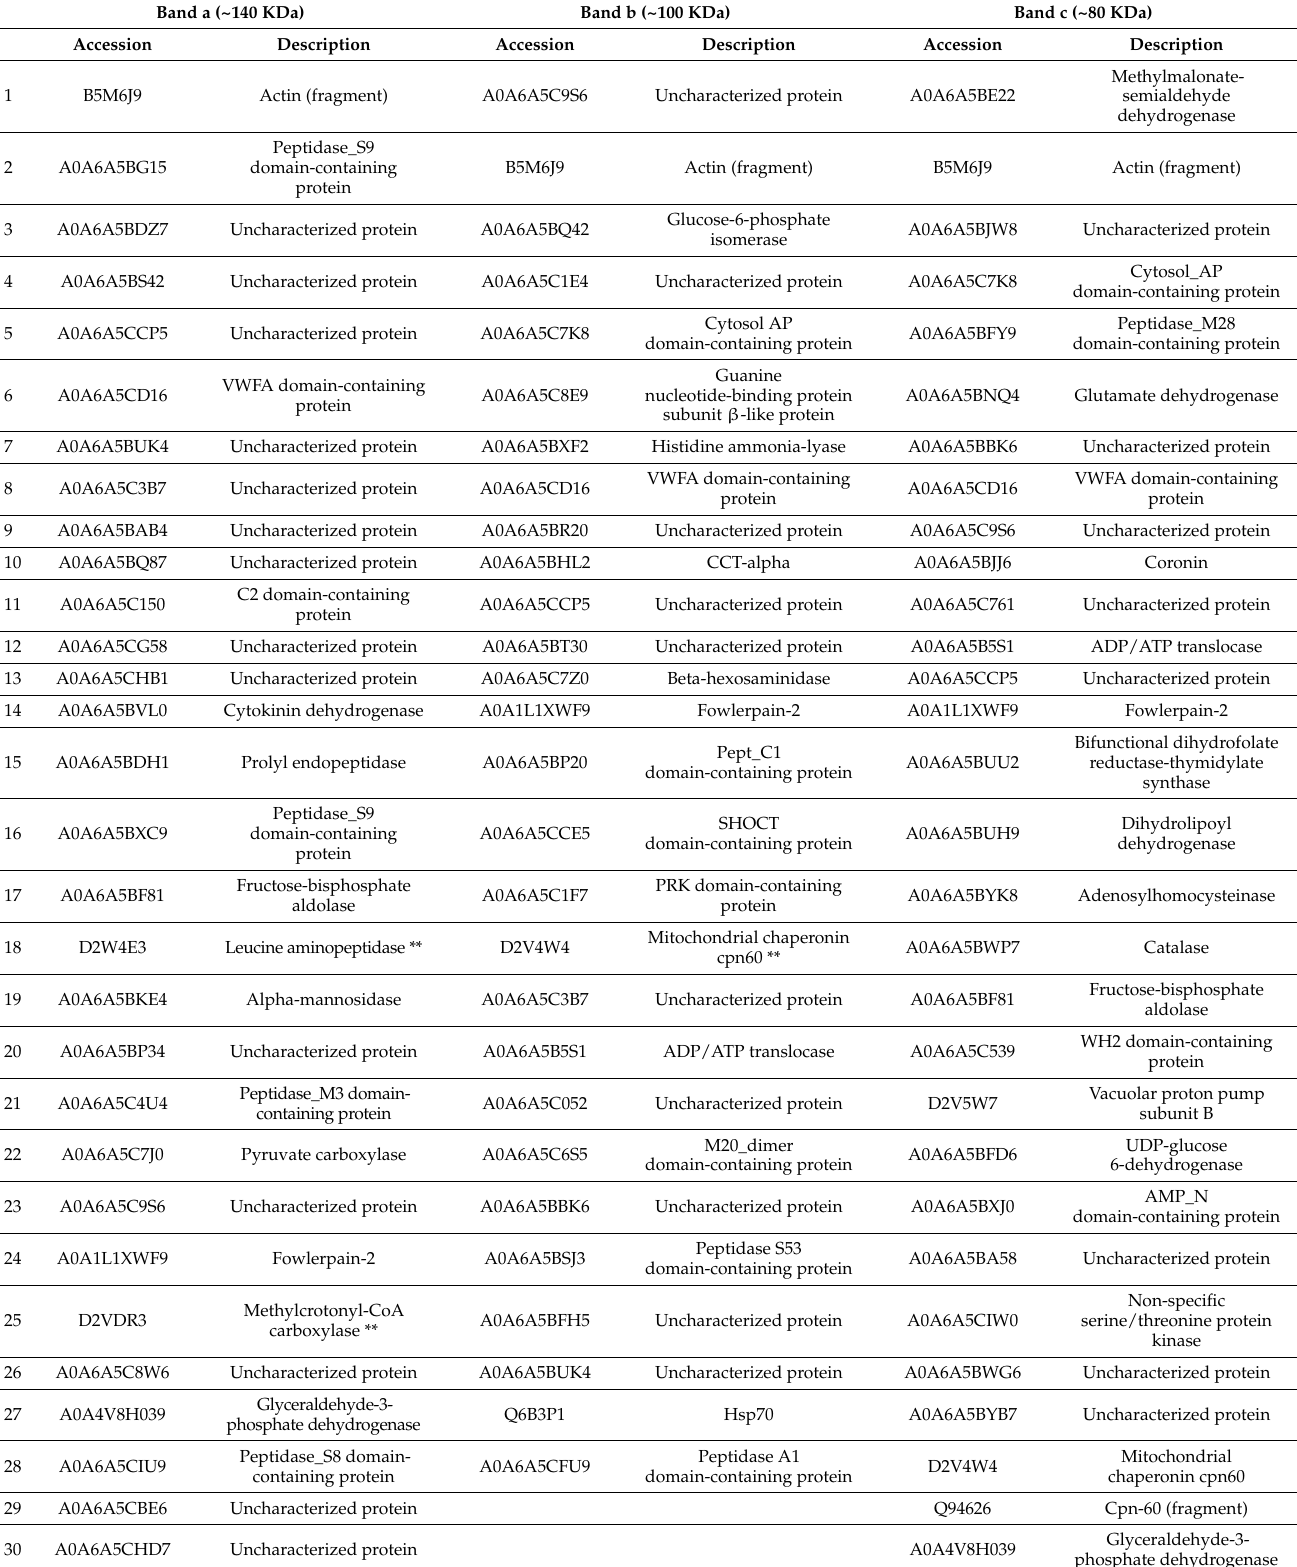
Table 1. Proteins identified by nano-LC-MS/MS in trypsin-digested immunorecognized bands (a–c) of extracellular vesicles of Naegleria fowleri after SDS-PAGE/Western blot analysis using rat anti- N. fowleri antibodies